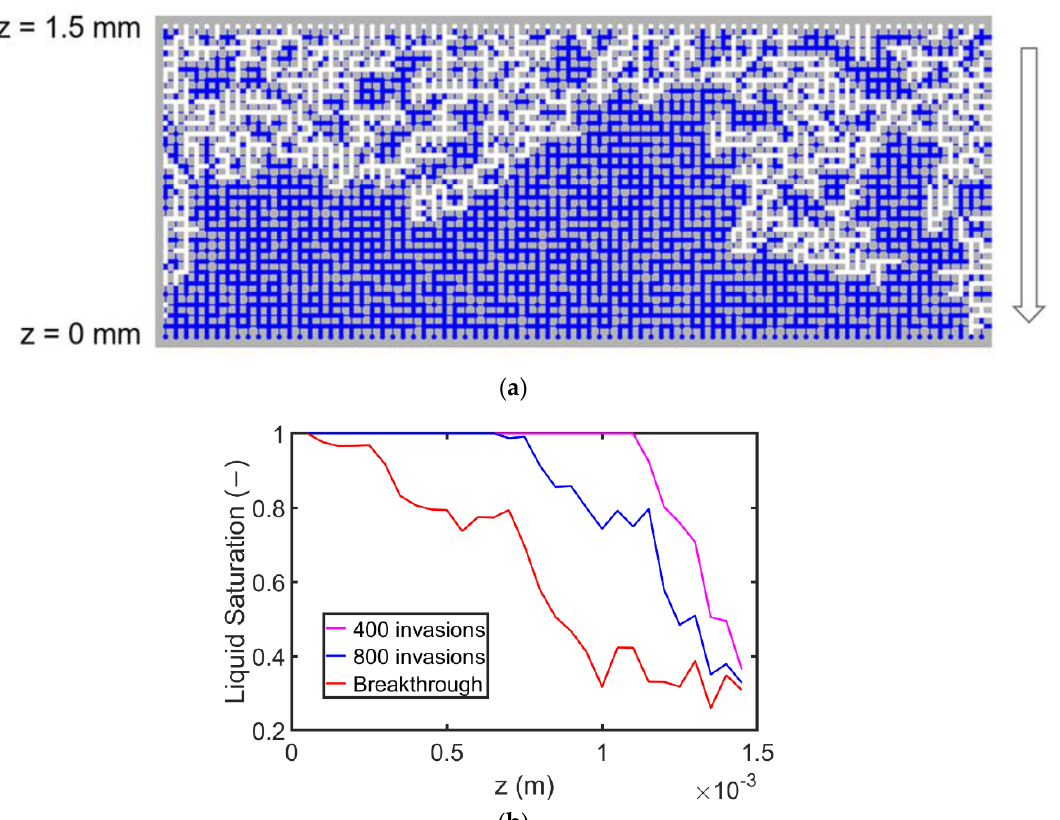
Figure 13. ( a ) Exemplary invasion patterns of the bimodal PN with porosity 71%. Liquid in blue, gas in white and solid in gray. Macro ‐ pores are represented by thicker lines. The arrow indicates the direction of gas invasion. ( b ) Saturation profiles for different overall number of invaded throats and pores from one drainage simulation.